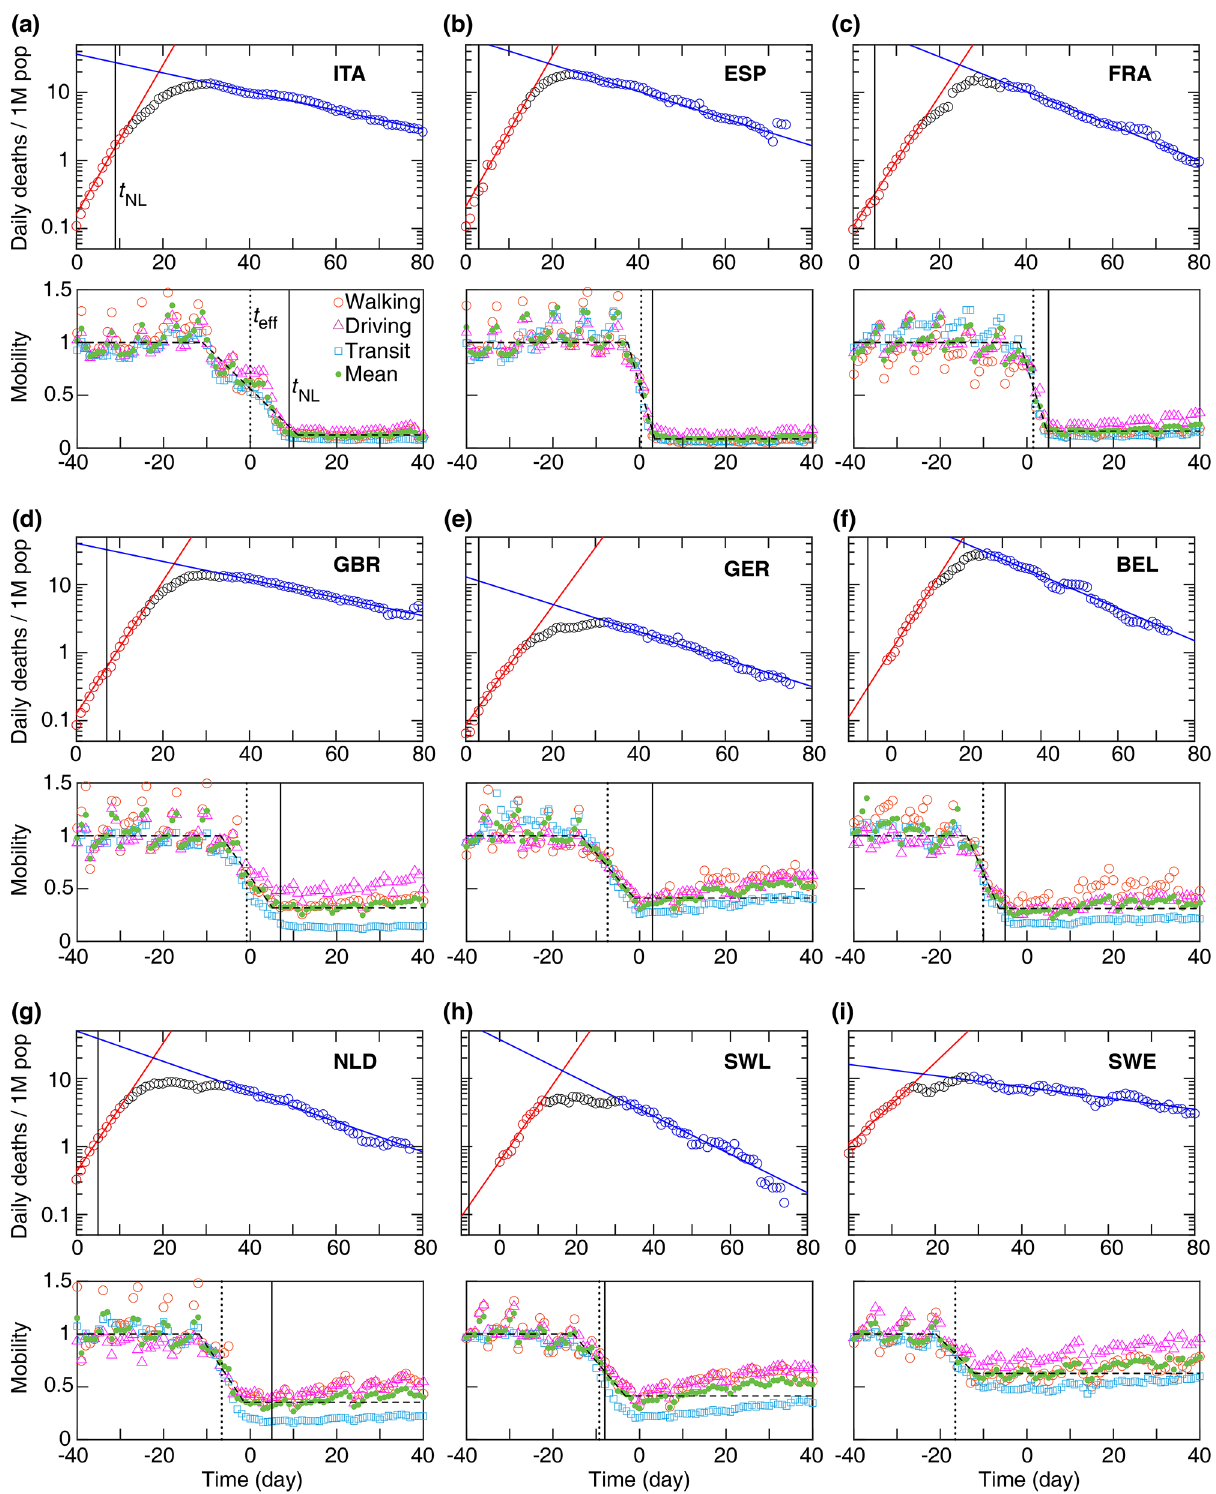
Figure 1. Daily death and mobility data for 9 European countries ( a – i ). Time 0 corresponds to the day when a country first reported ≥ 5 daily deaths. Top: Growth and decay phases (red and blue lines) were fitted using Eq. (1) to the data points visually highlighted by red and blue, respectively. Vertical line: national lock-down date t NL . Bottom: Mobile phone tracking data, normalized by the average values before the epidemic ( M 1 ). Quantitative parameters were extracted by a fit (dashed line) to the mean mobility data (green circles, average of walking, driving, and transit data) calculated using Eq. (3). Dotted vertical line indicates the effective lock-down date t eff calculated using Eq. (4). Fit parameters are summarised in Supplementary Tables 1 and